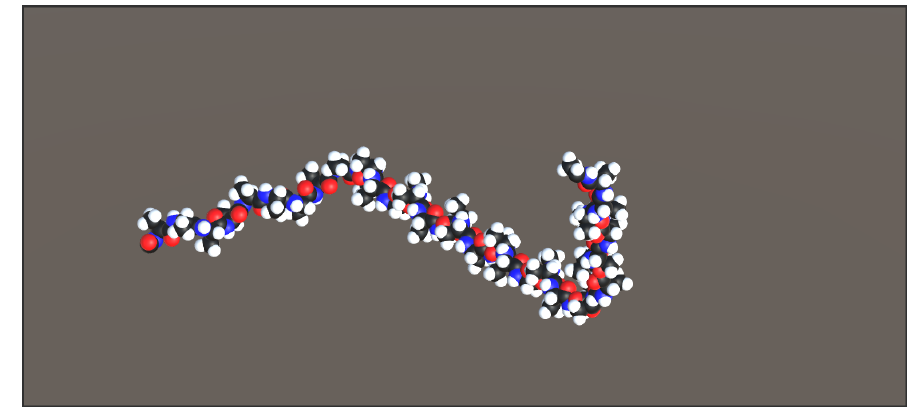
Figure 18. Code generated protein chains.